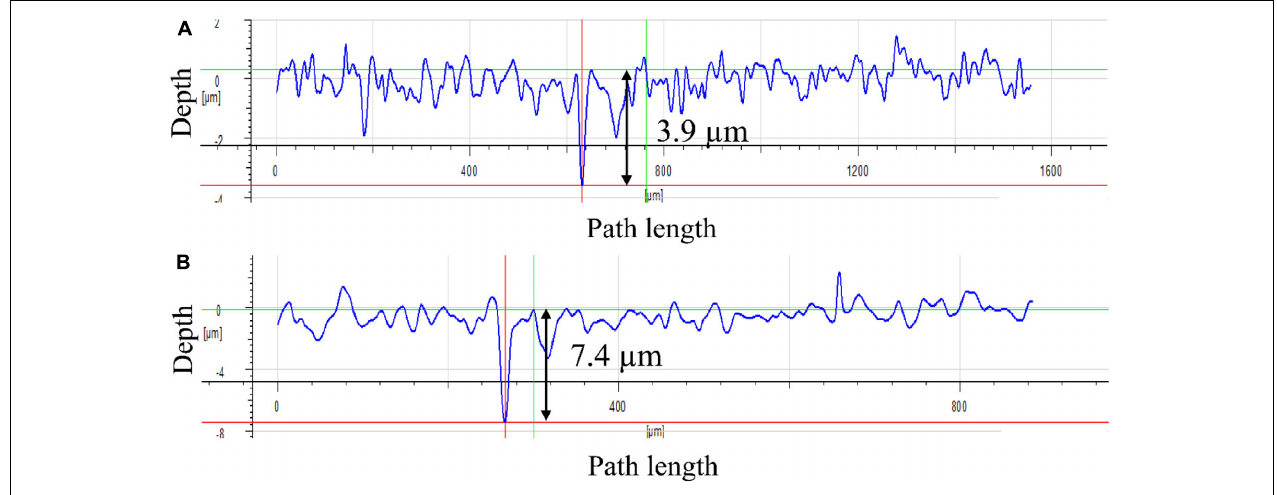
FIGURE 6 | Maximum pit depth on the coupon surface under IFM: (A) after 7-day incubation and (B) after 14-day incubation.